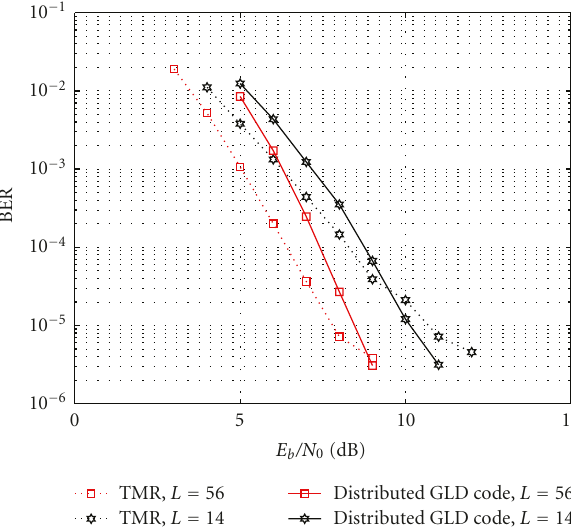
Figure 10: Performance comparison of distributed GLD codes ( R = 7 / 45) and turbo multiple relay scheme (TMR, R = 1 /